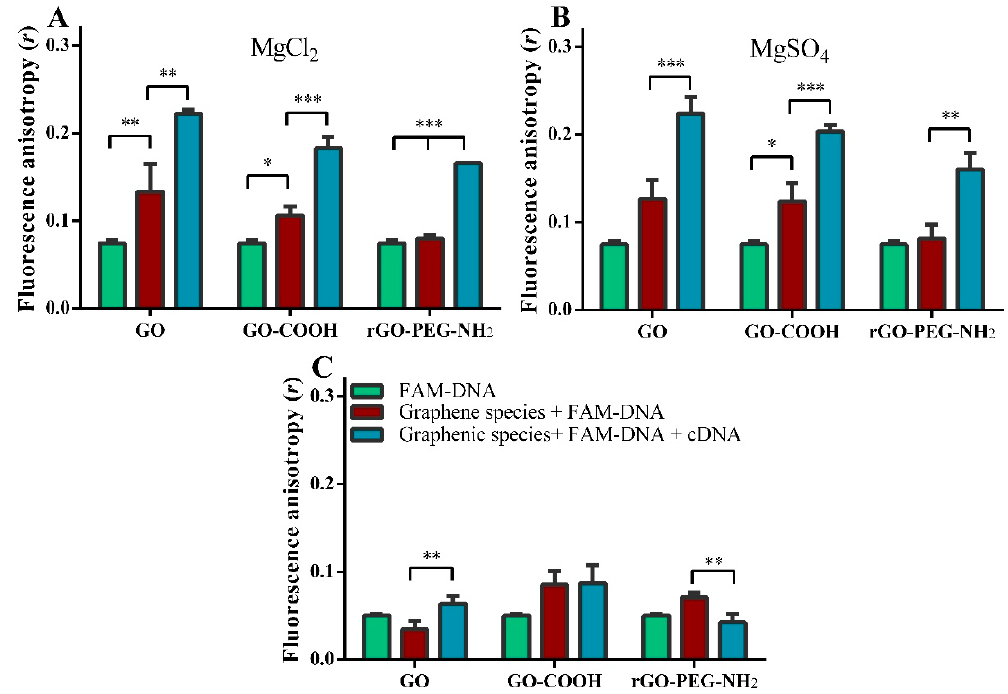
Figure 8. Fluorescence anisotropy in the presence of ( A ) MgCl 2 , ( B ) MgSO 4 and ( C ) the absence of magnesium ions. Concentrations: 100 nM FAM-DNA, 100 nM cDNA, 10 μ g/mL graphene oxide materials, 10 mM MgCl 2 and 10 mM MgSO 4 . (* p < 0.05, ** p < 0.01, *** p < 0.001).